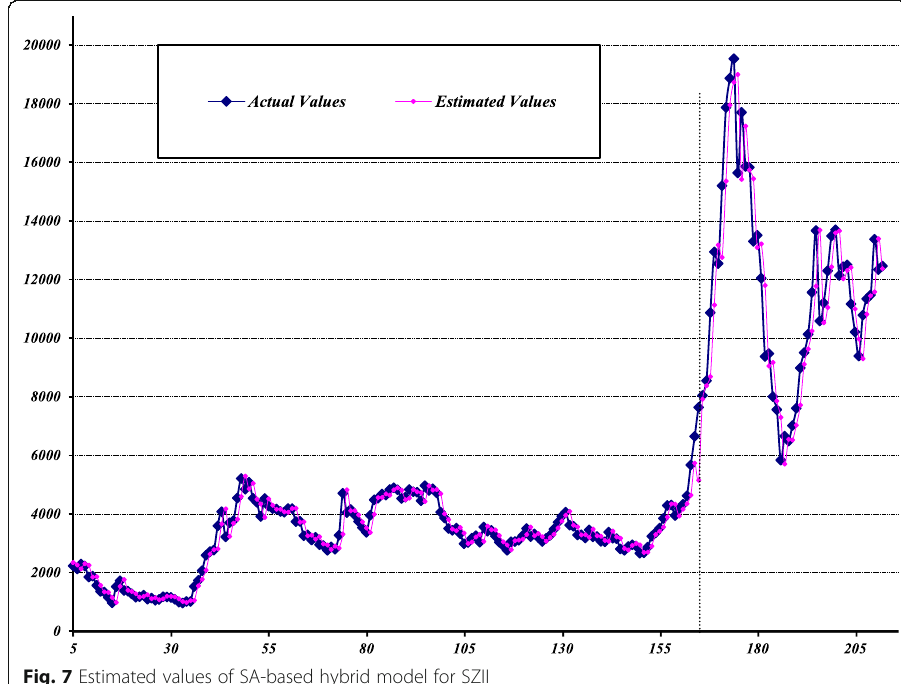
Fig. 7 Estimated values of SA-based hybrid model for